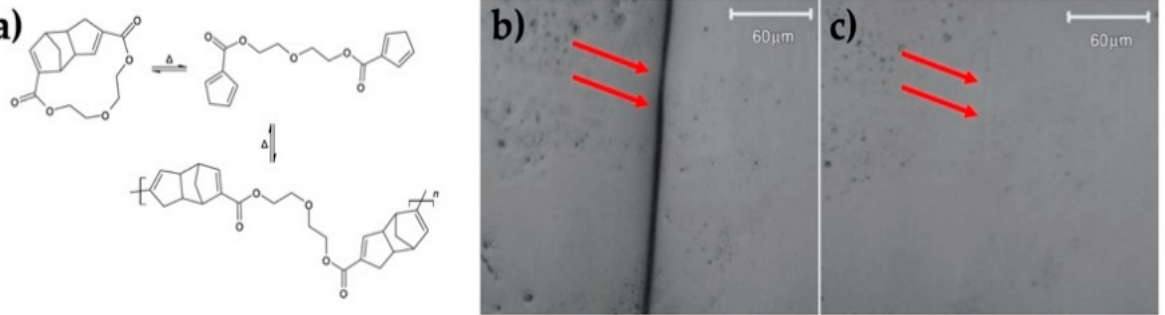
Figure 4. ( a ) Diels-Alder and retro Diels-Alder reactions of mendomer 401, ( b ) microcrack before and ( c ) after microcrack healing by resistive heating [38]. Adapted with permission from Park, J.S; Journal of Composite Materials; published by Sage, 2008.